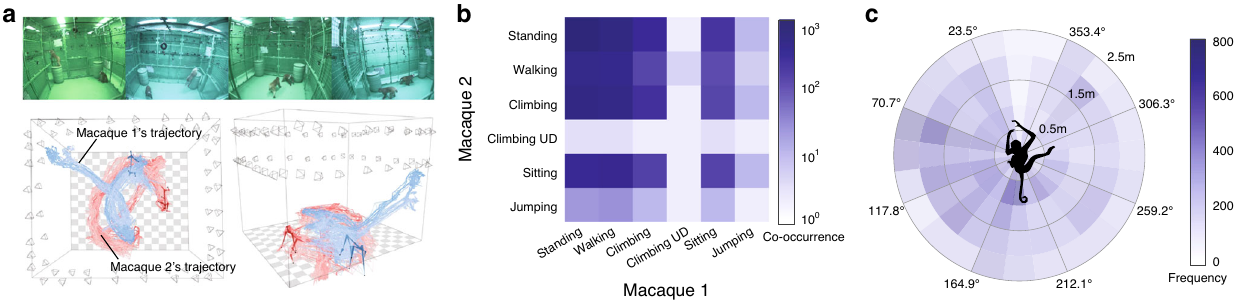
Fig. 7 Social interaction tracking. a OpenMonkeyStudio extends to tracking social interactions in non-human primates. Here we demonstrate the feasibility of tracking two rhesus macaque while they individually move inside the enclosure, crossing paths fully. Colors indicate two individuals. Top frames depict the scene of two individuals in the cage during different timepoints. b Co-occurrence of actions in social macaques. We used 3D poses to classify their actions to illustrate the co-occurrence of actions of two macaques in log scale. c Proxemics characterizes the social space, e.g., how the location of a macaque is distributed with respect to the other. We transformed the 3D coordinate of the second macaque to the fi rst macaque ’ s body centric coordinate system, i.e., 0 ◦ represents the fi rst macaque ’ s facing direction. We use the polar histogram of the transformed coordinate to visualize the proxemics of macaques.